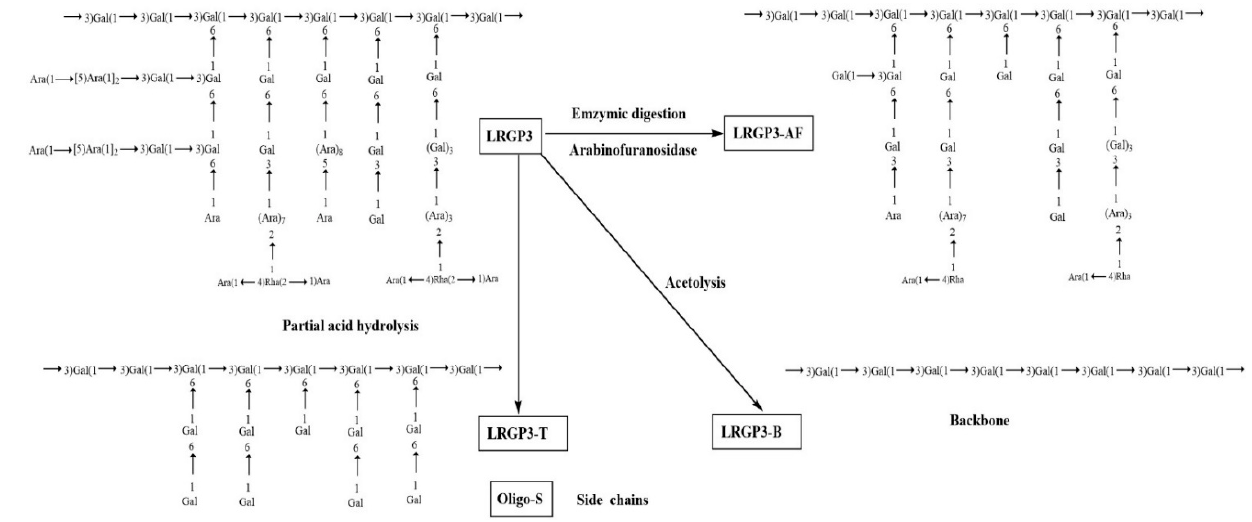
Figure 16. Schematic representation of the sequential degradation procedure of LRGP3.